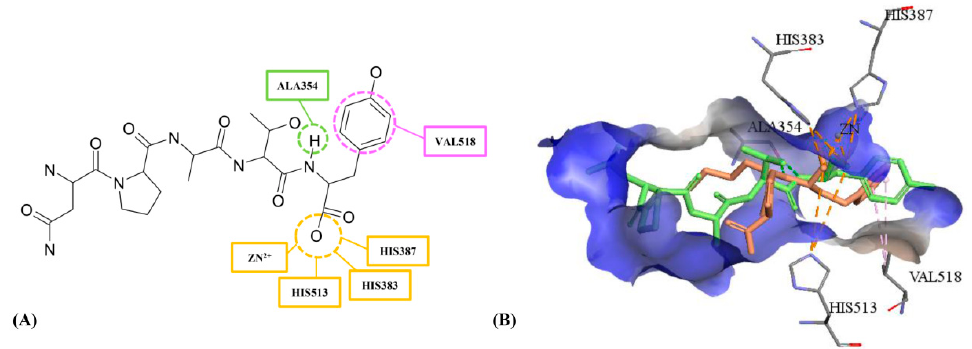
Figure 6. The 2D and 3D interaction analysis of NPATY based on the common features between pharmacophore and docking models: ( A ) 2D common interaction of NPATY included hydrophobic bonds with VAL518, hydrogen bond with ALA354, and electrostatic effects with HIS383, HIS387, HIS513 and Zn 2+ ; and ( B ) 3D common interaction of lisinopril (orange) and NPATY (green). The pink dash line represent the hydrophobic effect; the green dash line represent the hydrogen bond donor; and the orange dash line represent the electrostatic network.